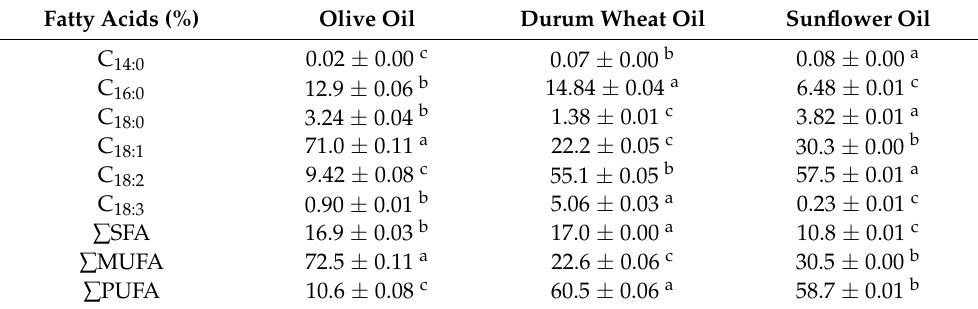
Table 3. Percentage of the main fatty acids in the olive oil, sunflower oil, and durum wheat oil used in the preparation of focaccia samples.